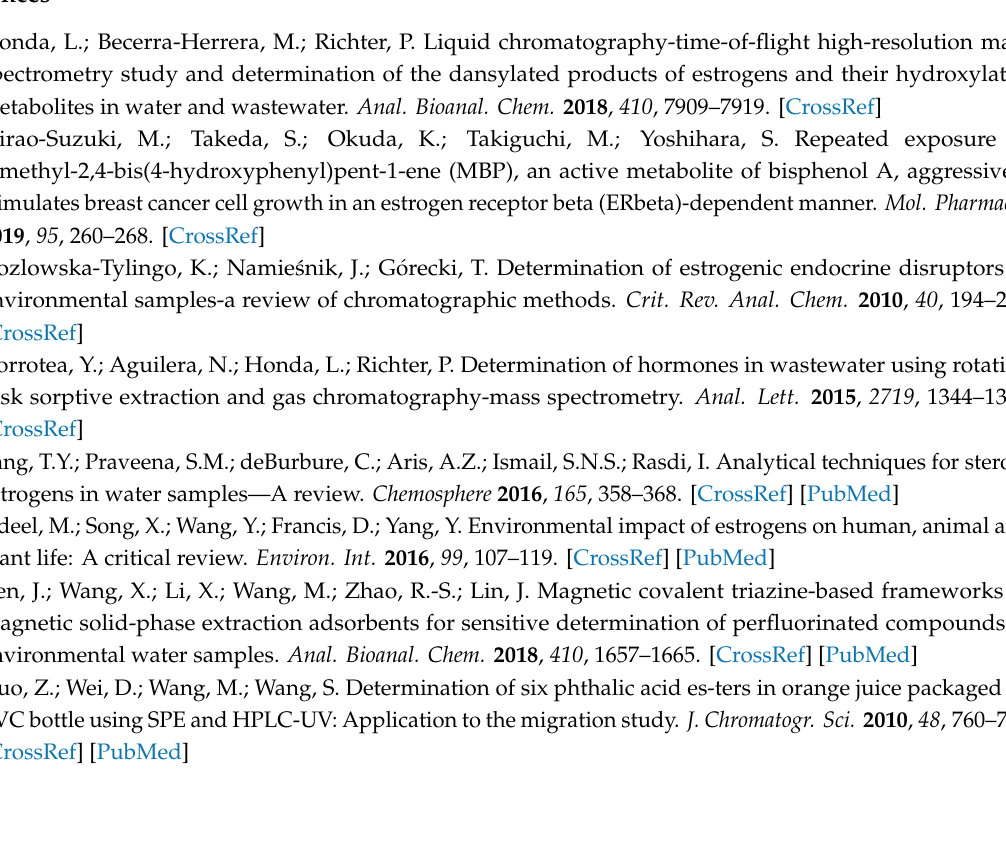
Supplementary Materials: The following are available online. Figure S1: The e ff ect of desorption time on the